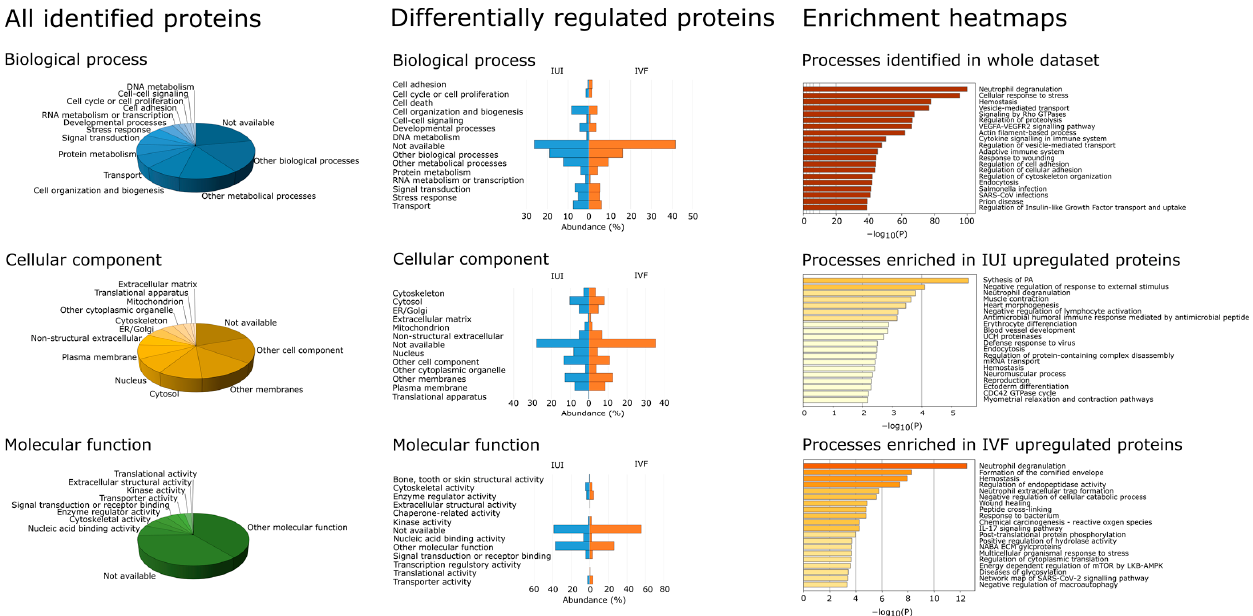
Figure 2. Protein annotation results for the cervical mucus proteome. Annotations for the three main GO term categories—biological function, cellular component, and molecular function—were generated using ProteomeDiscoverer for the complete cervical mucus proteome and for the sets of proteins exhibiting differential expression in the IUI and IVF samples. Additional annotations based on the Metascape [19] enrichment heatmap were also obtained for these three protein sets.